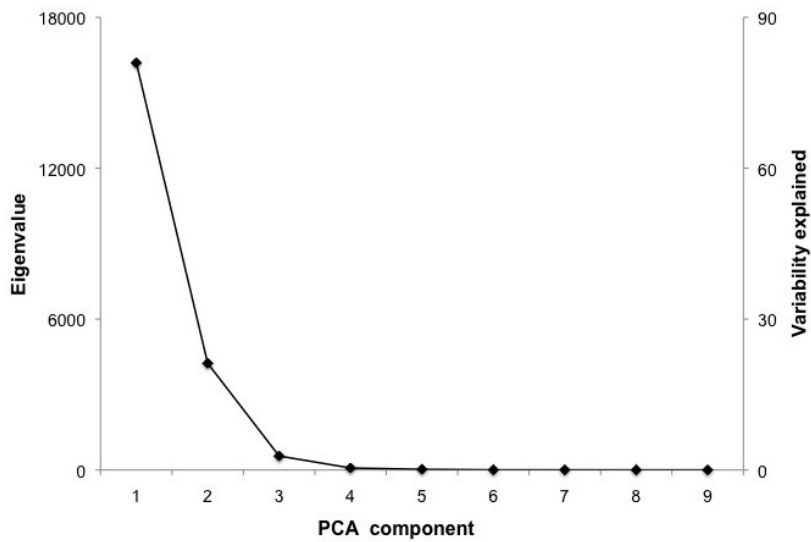
Figure 11. Scree plot of eigenvalues resulting from the PCA analysis of the visible and shortwave infrared ASTER bands (x-axis) and the variability explained by each component (y-axis).